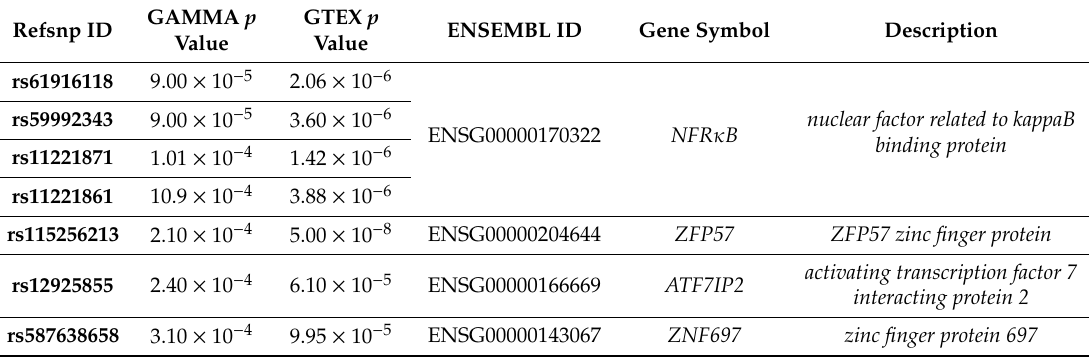
Table 3. Single nucleotide polymorphisms (SNPs) and eGenes significantly detected from muscle tissue, genotype-tissue expression (GTEx) version 6.